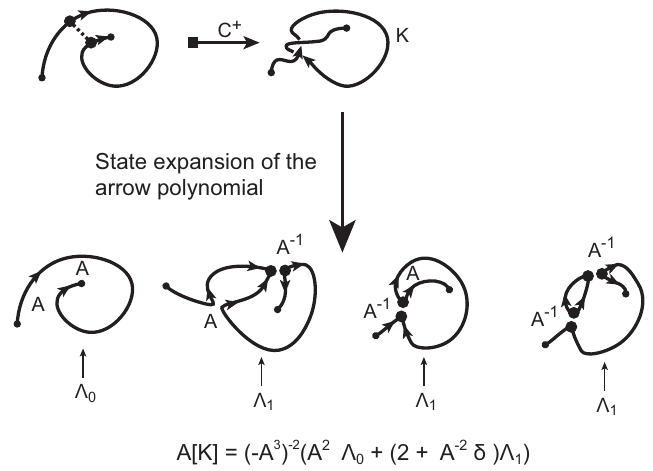
Figure 12. Computing the arrow polynomial of a simple